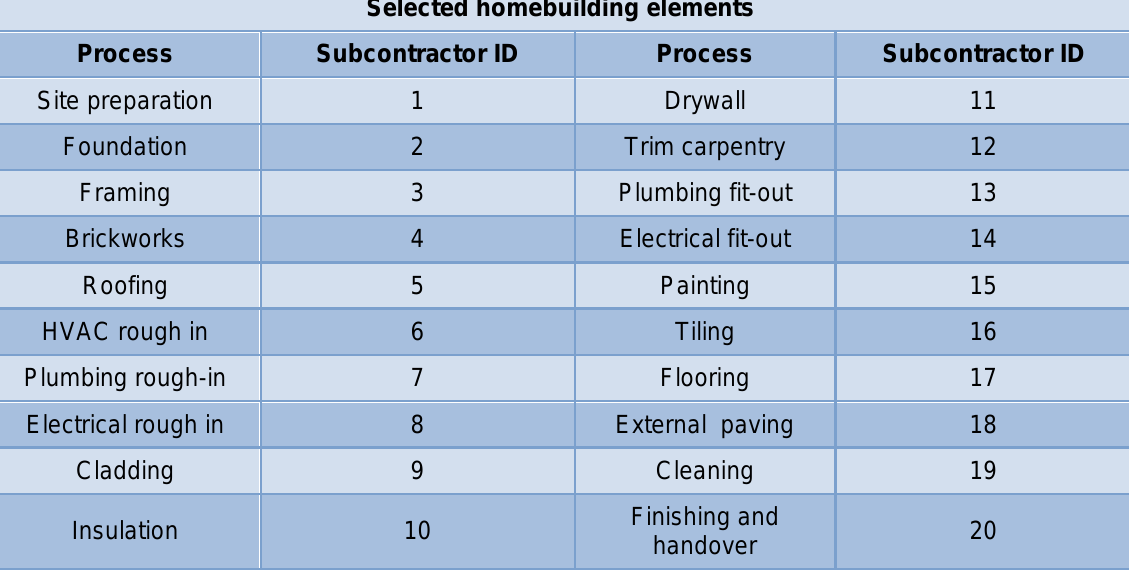
Table 1 Construction processes and related subcontractors